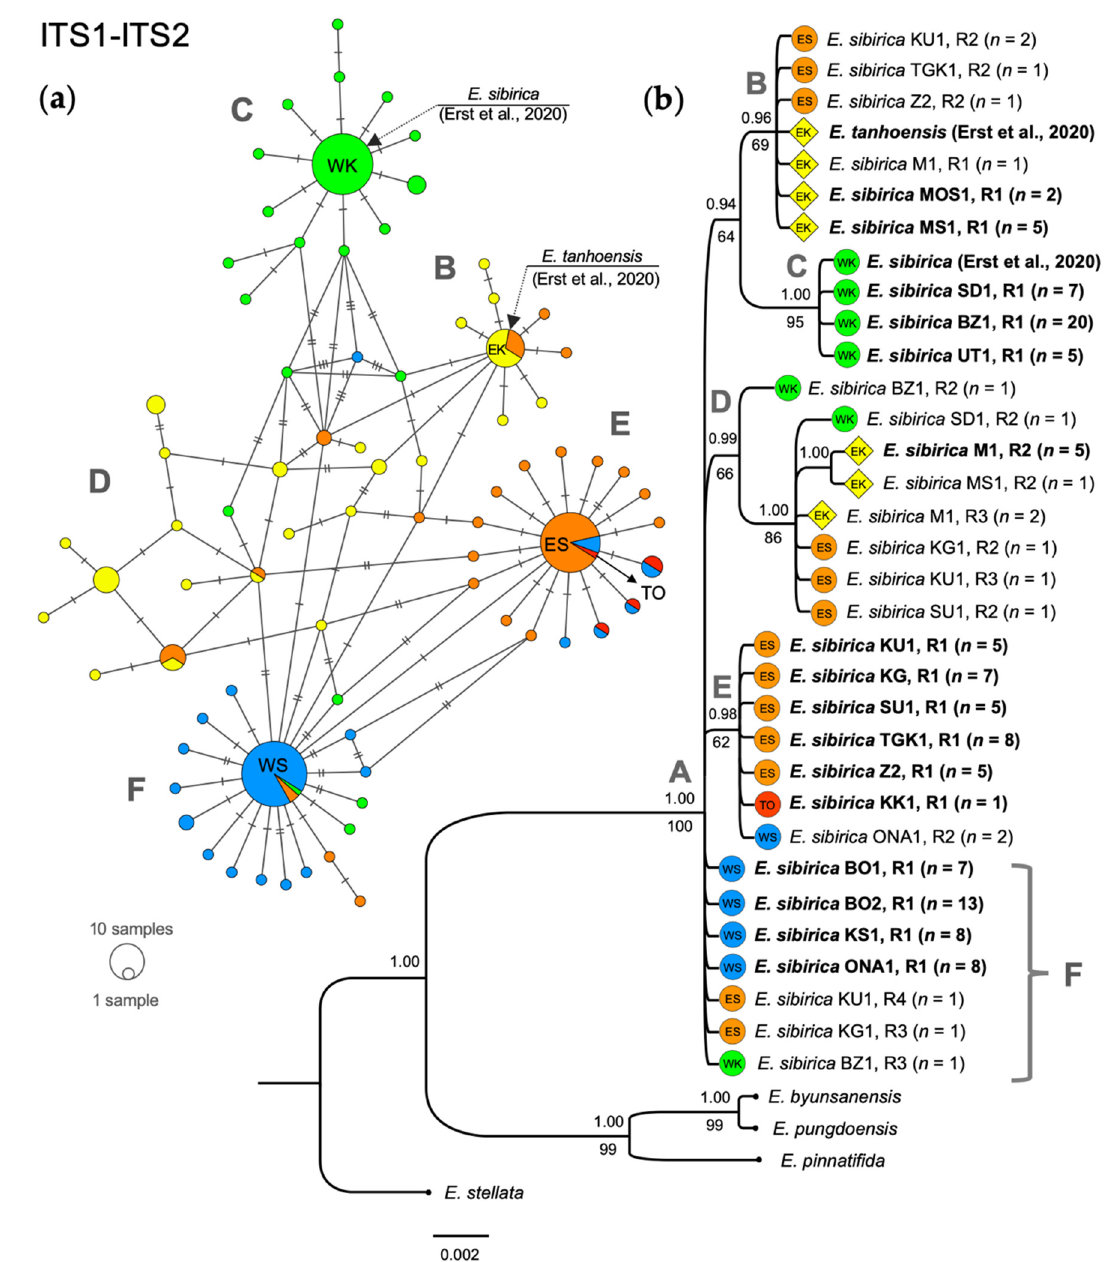
Figure 2. Diversity and phylogenetic relationships between ITS ribotype variants (R) in E. sibirica from different localities. The color patterns and names correspond to those in Figure 1. Capital letters indicate the groups discussed in the text. ( a ) Minimum spanning network based on multiple ITS variants identified by molecular cloning. Different ribotypes are presented as colored circles connected by lines, where hatch marks correspond to the numbers of the evolutionary events (substitutions). Circle size corresponds to the number of identical ribotypes sampled (see the circular scale); ( b ) BI phylogram of main ITS ribotypes. Posterior probabilities are indicated above the branches, Bootstrap values of respective clades on the ML tree below the branches. The number of ribotype copies found by molecular cloning is indicated in brackets next to the branch names. ITS variants used for the further joint ITS + ptDNA analysis (Figure 4) are indicated in bold. The scale bar represents the number of expected changes (substitutions) per site corresponding to a unit of branch length.